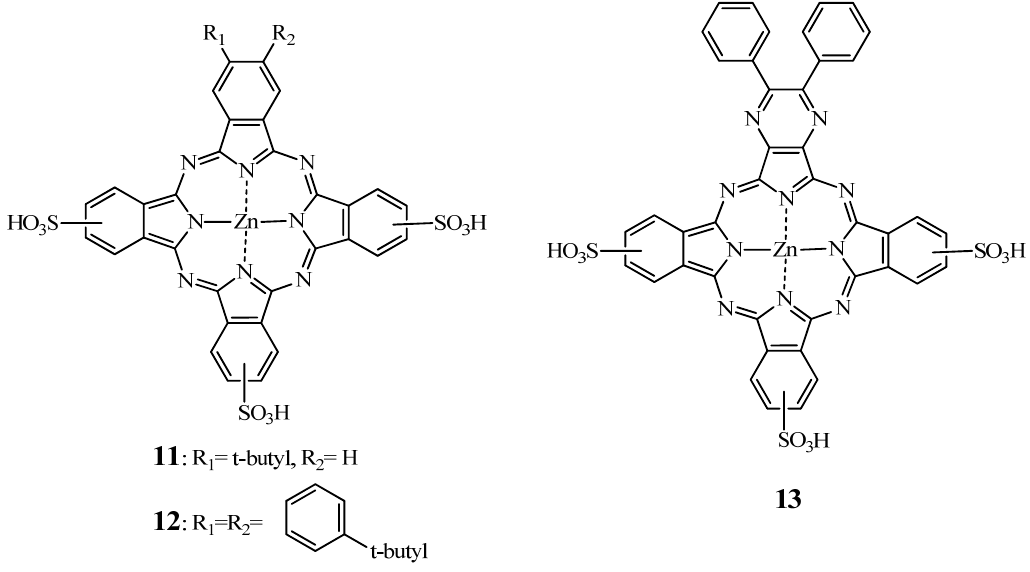
Figure 6. Structures of compounds 11 , 12 and 13